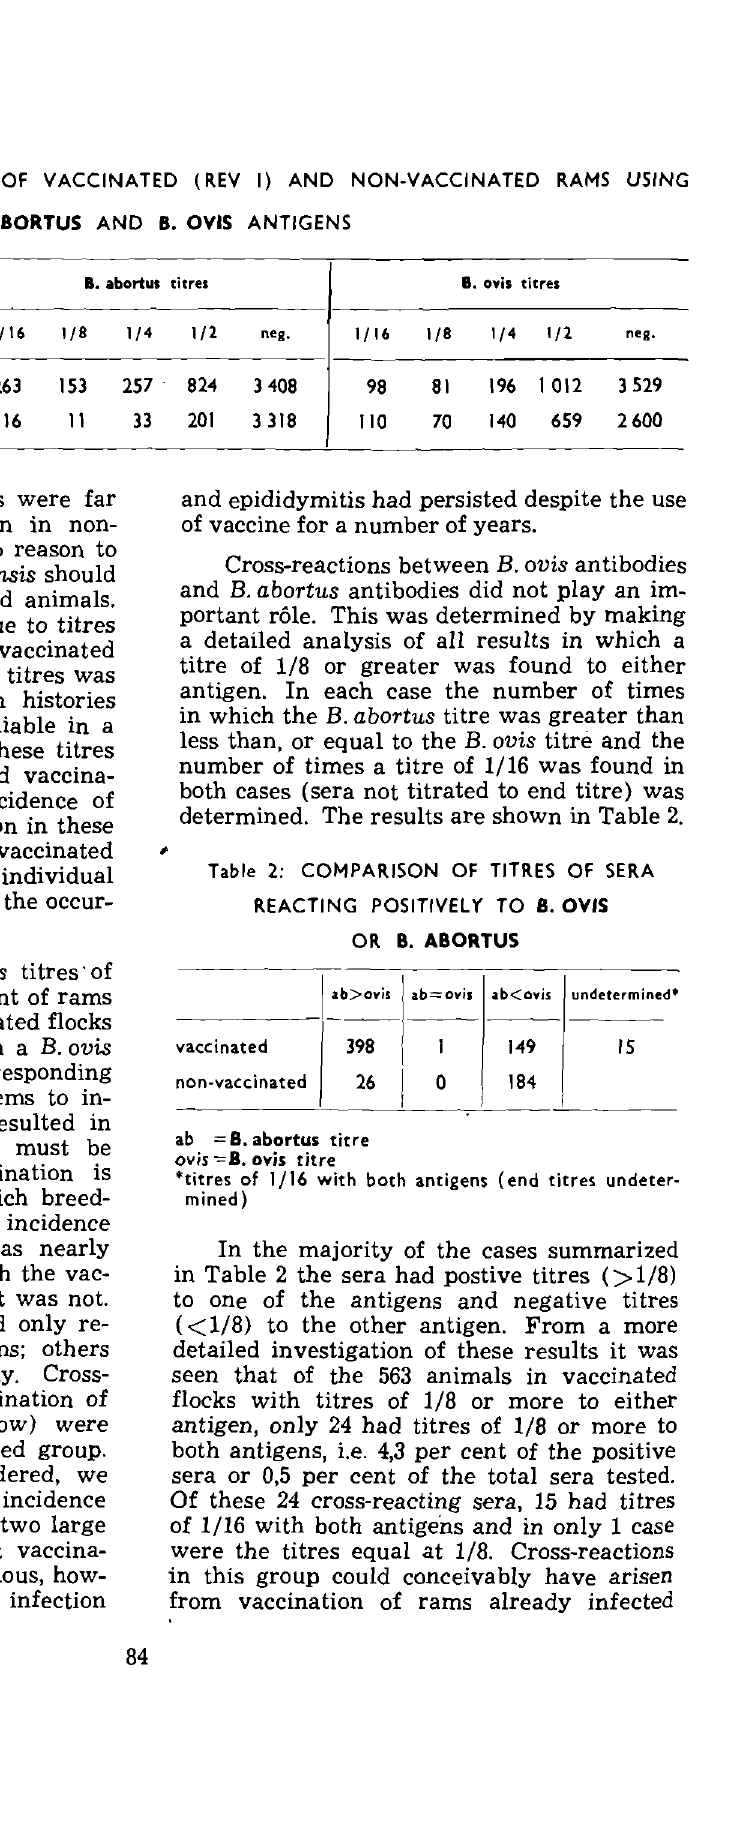
Table 1: CF TlTRES OF THE SERA OF VACCINATED (REV I) AND NON-VACCINATED RAMS USING